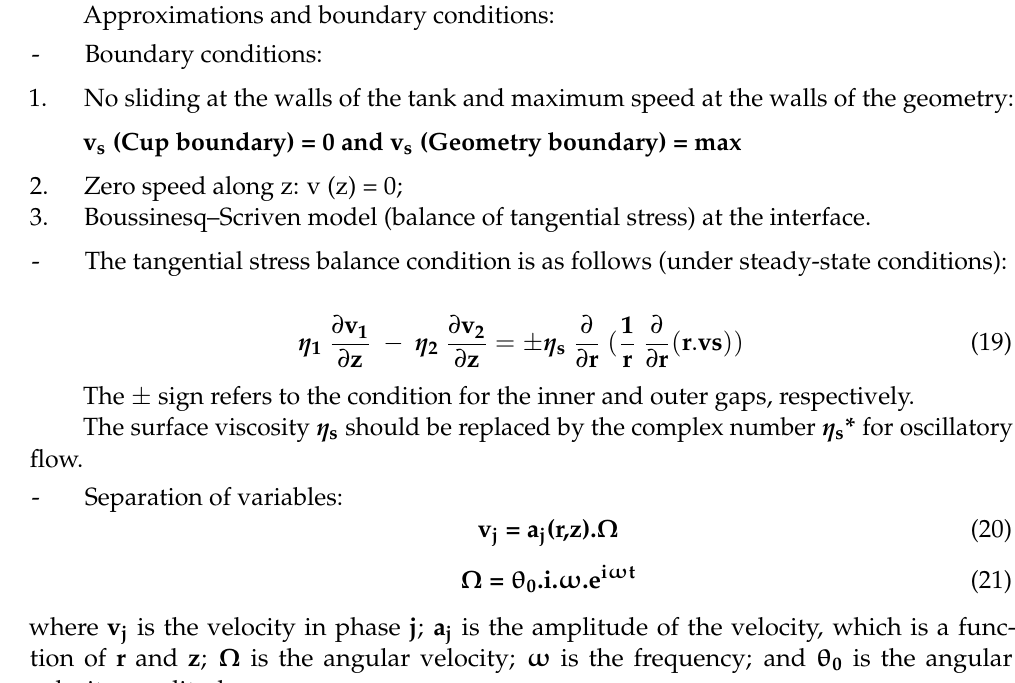
Figure 7. Tangential stress balance.